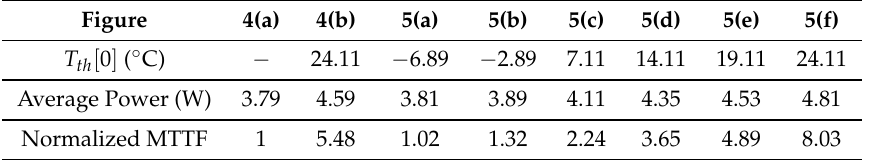
Table 1. Comparisons of T th , average power consumption, and normalized